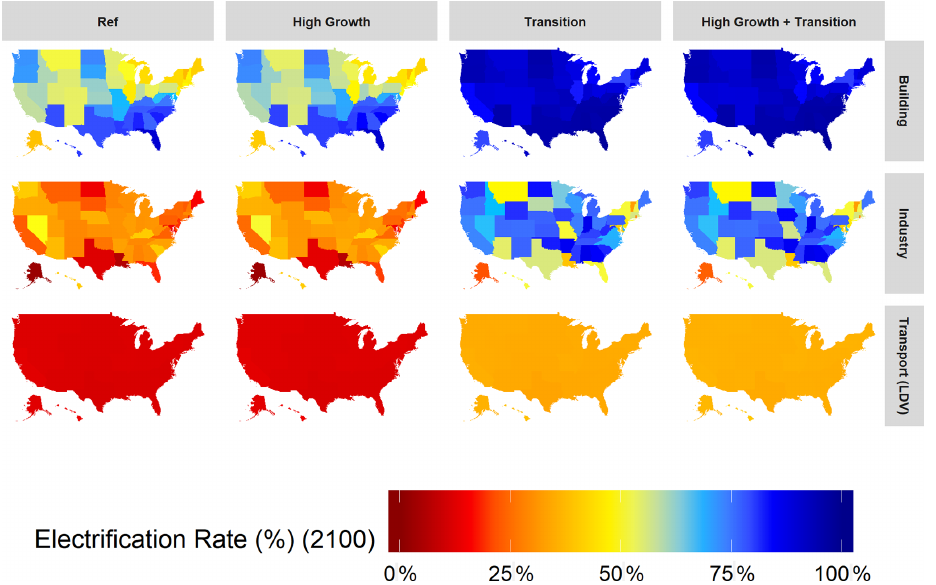
Figure 4. Electricity share of final energy by state, scenario, and end-use sector (building, industry, passenger vehicles) in 2100. Note that because electric drivetrains are more energy efficient than internal combustion engines, the share of passenger transportation service provided by electricity (BEVs) in the scenarios will exceed the energy consumption shares shown in this figure. A plot of passenger vehicle electrification by share of transportation service (passenger miles traveled) is provided as Fig.